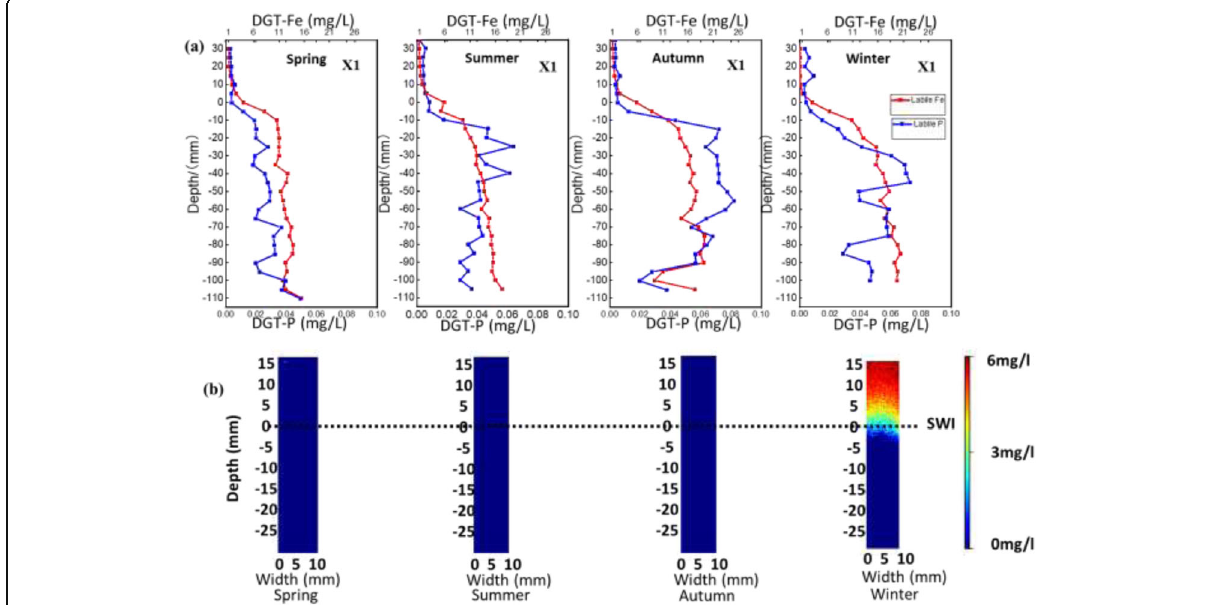
Fig. 3 Seasonal variations at sampling site X1. a The DGT-labile P and labile Fe concentrations with depth at the sediment-water interface (SWI) and b oxygen concentration at the SWI (2D imaging) of Tianbao Reservoir. The position of the SWI is represented by